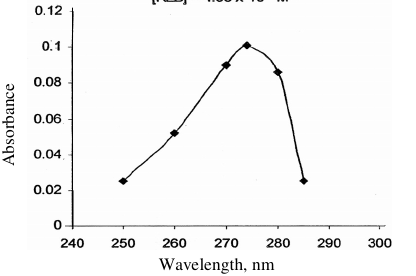
Figure 2. Absorption spectrum of REB in methanol (UV reference method)